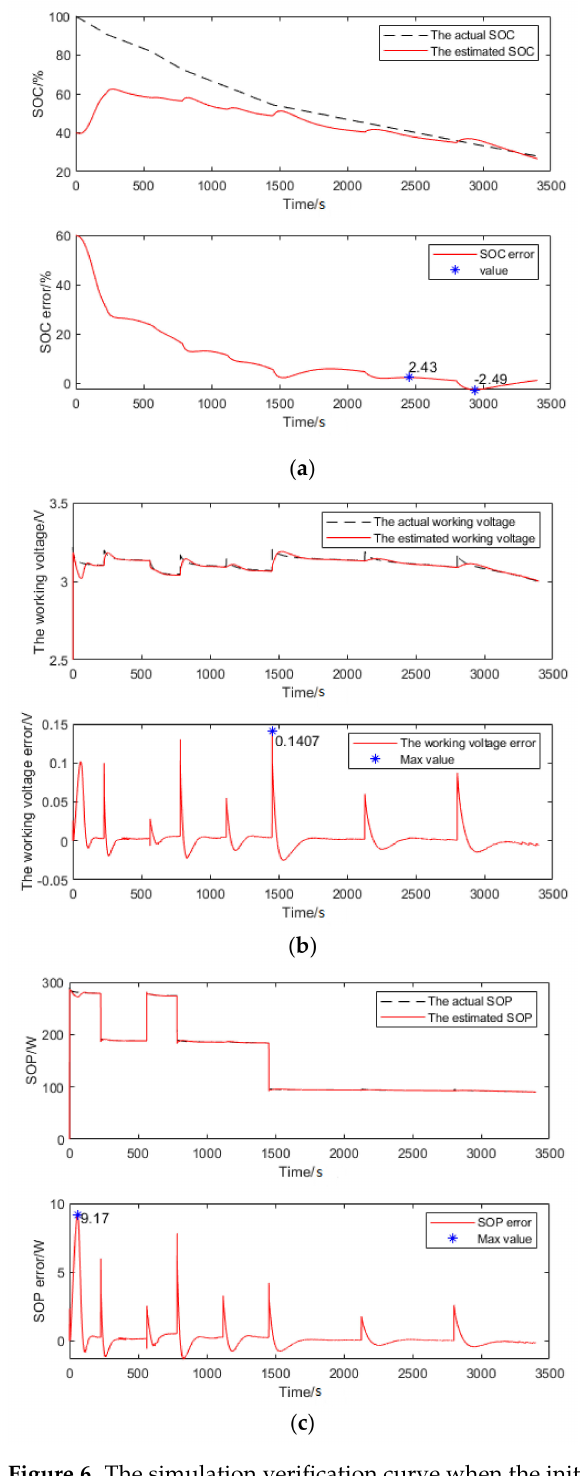
Figure 6. The simulation verification curve when the initial value of the SOC is 40%. ( a ) The SOC estimation and error curves. ( b ) The working voltage estimation and error curves. ( c ) The SOP estimation and error